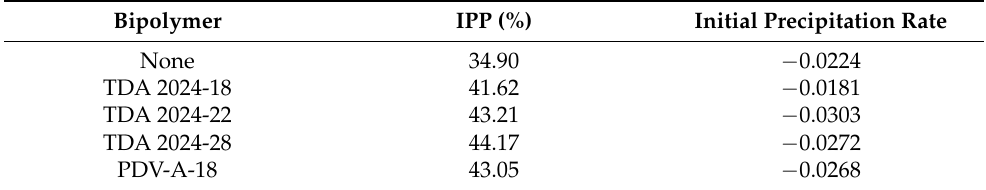
Figure 6. IPP of asphaltenes in model oils without and with bipolymers at 500 ppm. Table 5. IPP and asphaltene precipitation rate of asphaltenes in model oils with different bipolymers at 500